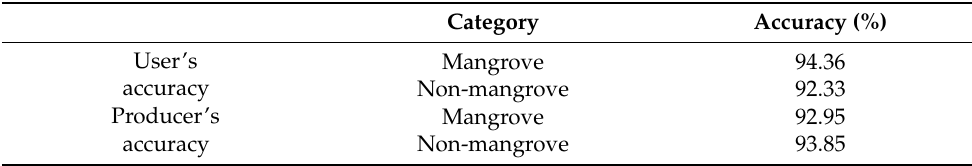
Table 2. Accuracy of mangrove extraction in 2019.